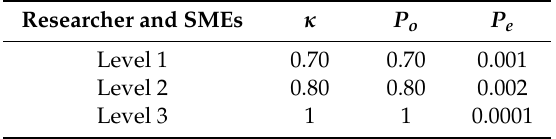
Table 4. Derived agreement statistics in all levels for researcher and AIB Subject Matter Expert (SME).